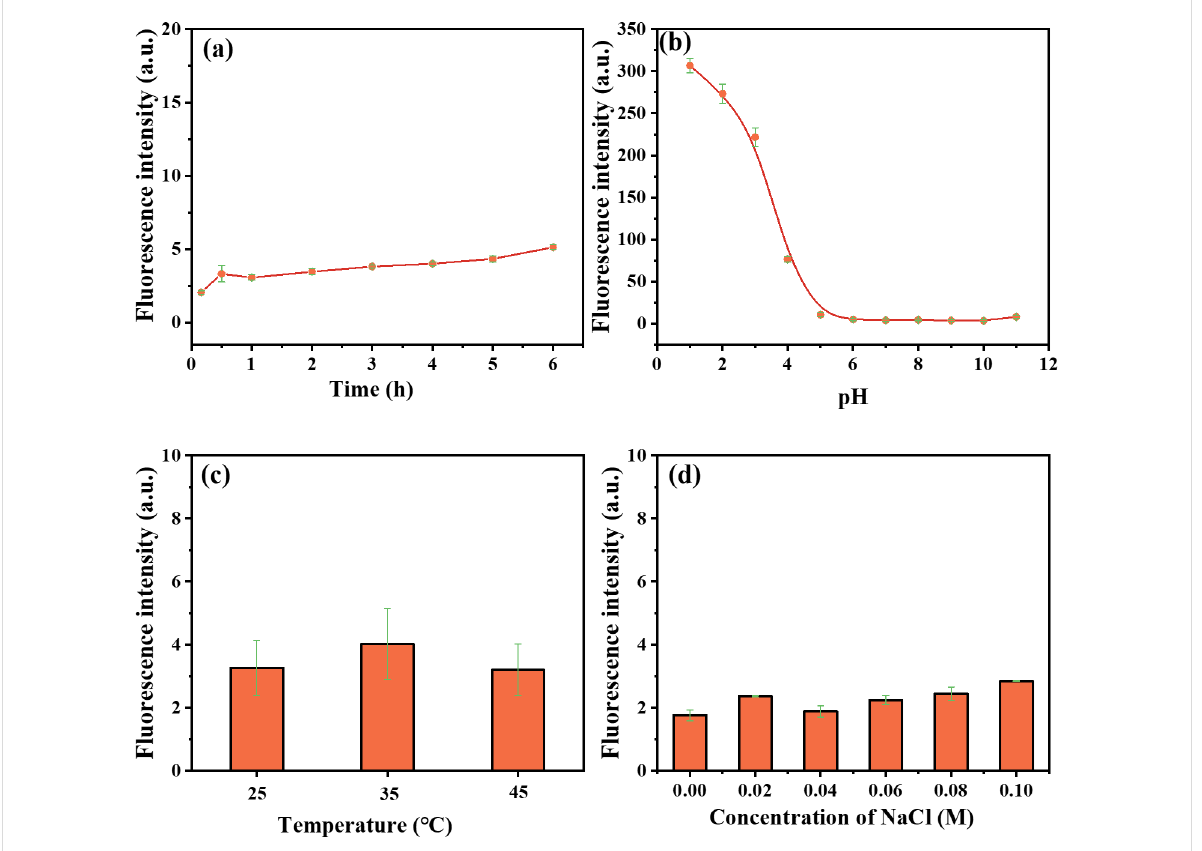
Figure 4: Fluorescence intensity of GNP-GSH-Rh6G2 in HEPES/CH 3 OH buffer (1:1 (v/v), 50 mM) as a function of (a) time, (b) pH value, (c) tempera- ture, and (d) NaCl